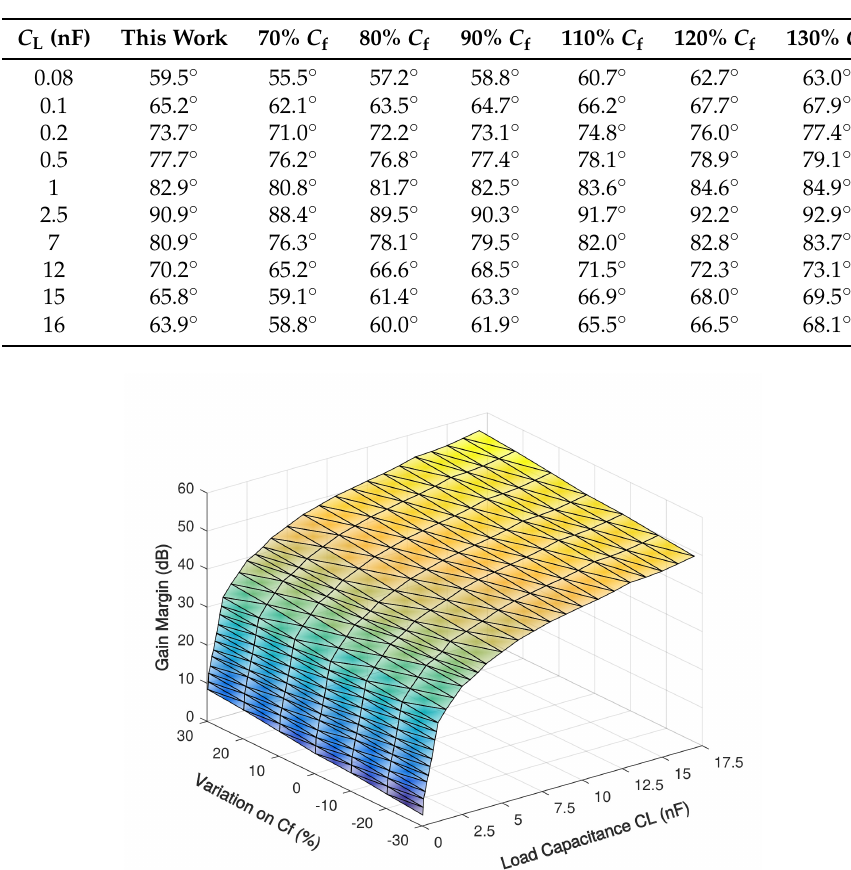
Table 4. Phase margin over variations on Miller compensation capacitor.